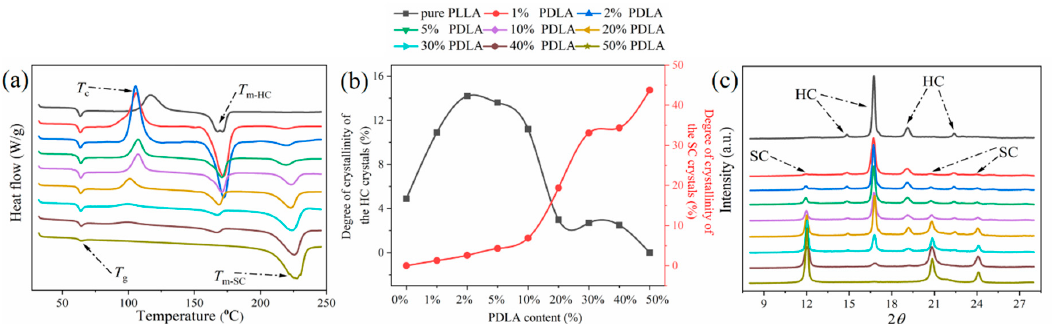
Figure 1. ( a ) DSC curves, ( b ) degree of crystallinity, and ( c ) XRD data of pure poly( L -lactic) acid (PLLA) and poly( D -lactic) acid (PDLA)/PLLA blends with different PDLA contents.